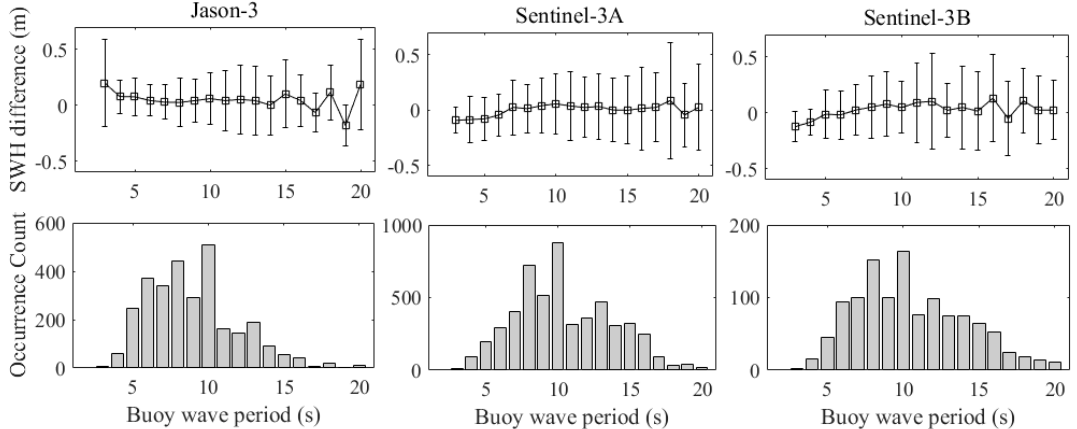
Figure 14. Dependence of the statistical parameters of SWH differences between the Jason-3, Sentinel- 3A, and Sentinel-3B altimeters and the NDBC buoys on buoy wave period.